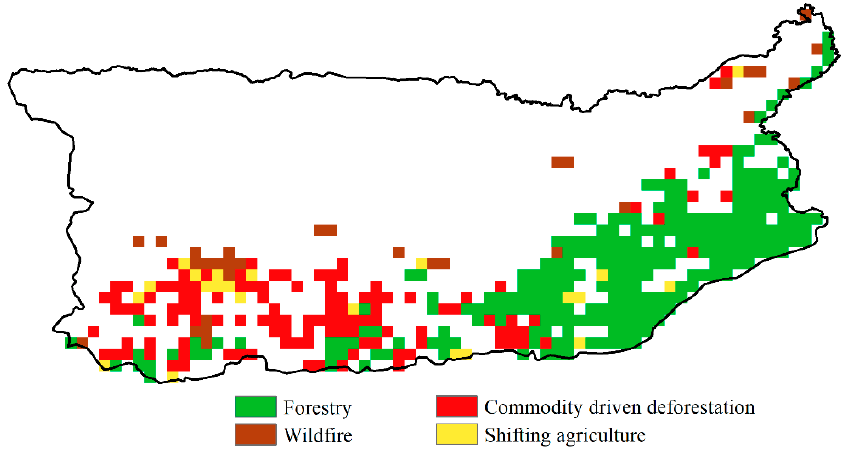
Figure 14. Distribution of drivers of forest loss in the Eastern Himalayas [56].